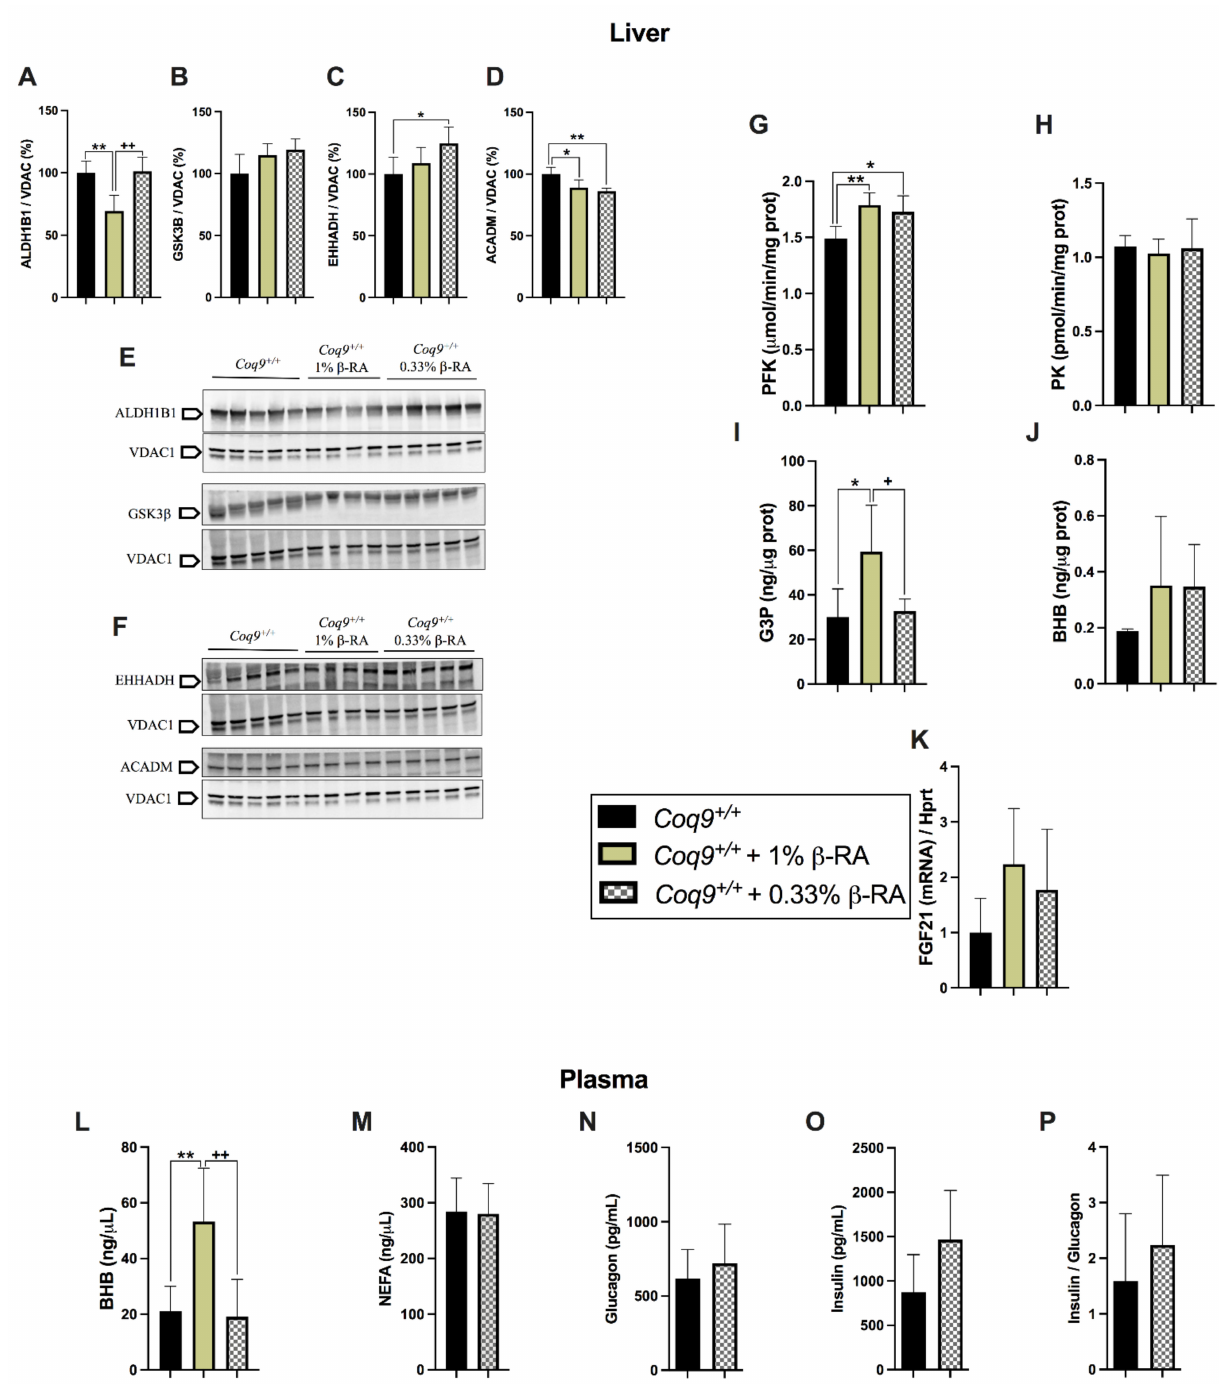
Figure 6. Metabolic characterization of liver and plasma after the treatment with β -RA in the Coq9 +/+ mice. ( A – F ) Levels of the proteins ALDH1B1 ( A , E ), GSK3 β ( B , E ), EHHADH ( C , F ), and ACADM ( D , F ) in the liver of the Coq9 +/+ mice treated with β -RA at 1 and 0.33%. VDAC1 was used as a loading control. The experiments were performed in tissue homogenate. ( G – J ) Activities of the glycolytic enzymes phosphofructokinase (PFK) ( G ) and pyruvate kinase (PK) ( H ) in the liver; levels of glycerol-3-phosphate (G3P) in the liver ( I ); levels of β -hydroxybutyrate (BHP) in the liver ( J ). ( K ) Levels of the FGF21 mRNA in the liver. ( L – P ) Levels of β -hydroxybutyrate (BHP) ( L ), non-esterified fatty acids (NEFA) ( M ), glucagon ( N ), and insulin ( O ) in the plasma of the Coq9 +/+ mice treated with β -RA; glucagon/insulin ratio ( P ) in the plasma of the Coq9 +/+ mice treated with β -RA. Tissues from mice at 3 months of age. Data are expressed as mean ± SD. * p < 0.05, ** p < 0.01, differences versus Coq9 +/+ . + p < 0.05, ++ p < 0.01, differences versus Coq9 +/+ after 1% β -RA treatment. One-way ANOVA with Tukey’s post hoc test or Mann–Whitney (nonparametric) test; n = 5–7 for each